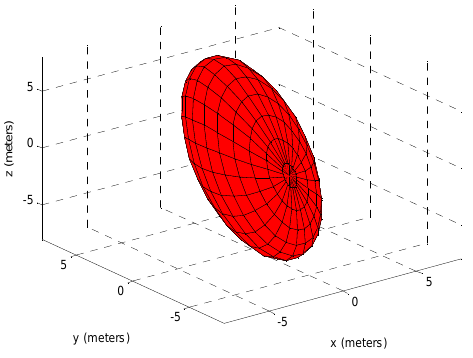
Figure 14. Predicted 0.9p error ellipsoid (0% temporal correlation)